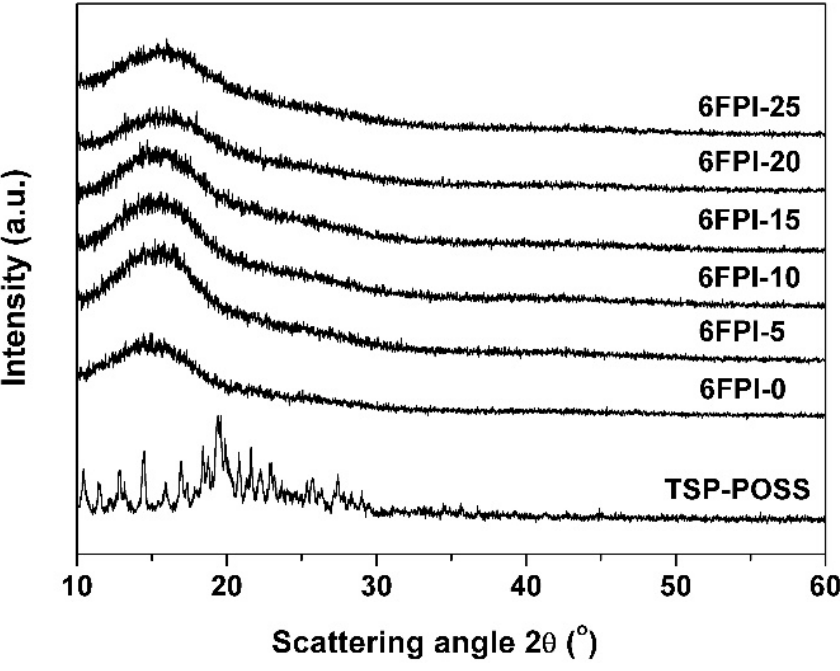
Figure 4. ATR-FTIR spectra of 6FPI-POSS composite films. The XRD plots of the PI films together with the TSP-POSS additive were shown in Figure 5. TSP-POSS exhibited obvious crystalline features with scattering angles in the range of 10 ◦ to 30 ◦ . However, only blunt absorption peaks instead of sharp ones for TSP-POSS were observed in the spectra of the PI composite films, indicating the good compatibility between TSP-POSS and PI matrix.